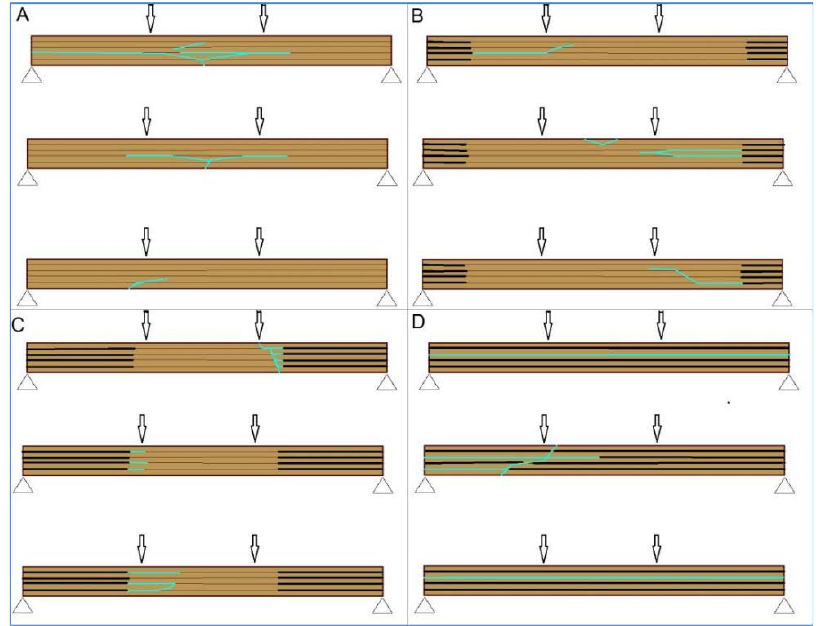
Figure 1. Possible failures of GL timber beam in fire event: ( A ) failure without delamination; ( B ) delamination occurs at the supports; ( C ) partially developed delamination ( D ) delamination occurs along the entire GL timber beam